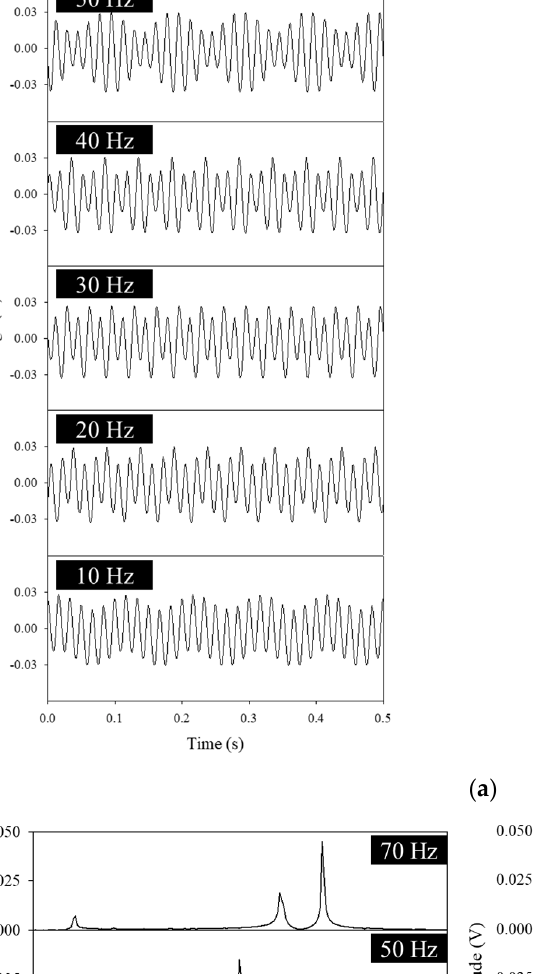
( b ) Figure 5. ( a ) Fast Fourier transform (FFT) matching according to the input frequencies and ( b ) nar- row ranges of frequencies. Figure 6a shows the output voltages and applied loads at 10 Hz and 100 Hz, and it can be seen that the output voltage appeared according to the load that matched the fre- quency. Figure 6b shows the piezoelectric output voltages for various frequencies with a load of 200 gf. These voltages allowed us to evaluate the performance for direct mechani- cal force and sound − frequency sensing. Relatively high voltages were outputted due to large deformations caused by direct stronger forces that were stronger than those caused by sound, and the trend of the waveform’s period changed at 30 Hz, like that of sound. However, above 90 Hz, it was difficult to identify the form characteristics using the graphs.